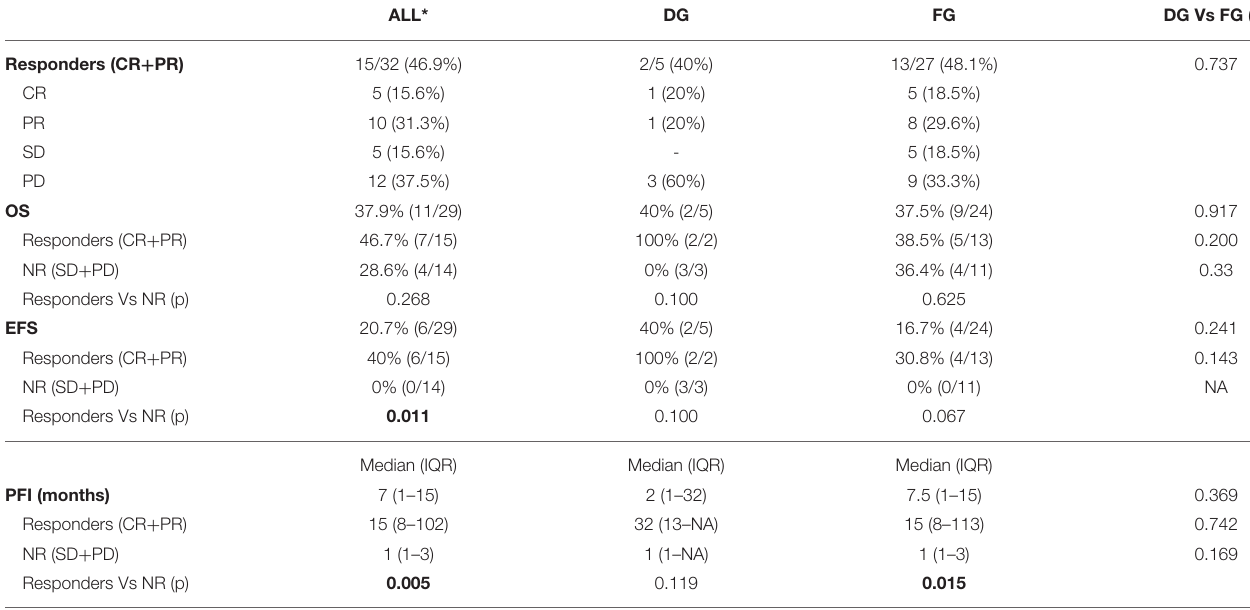
TABLE 2 | Outcomes of MIBG